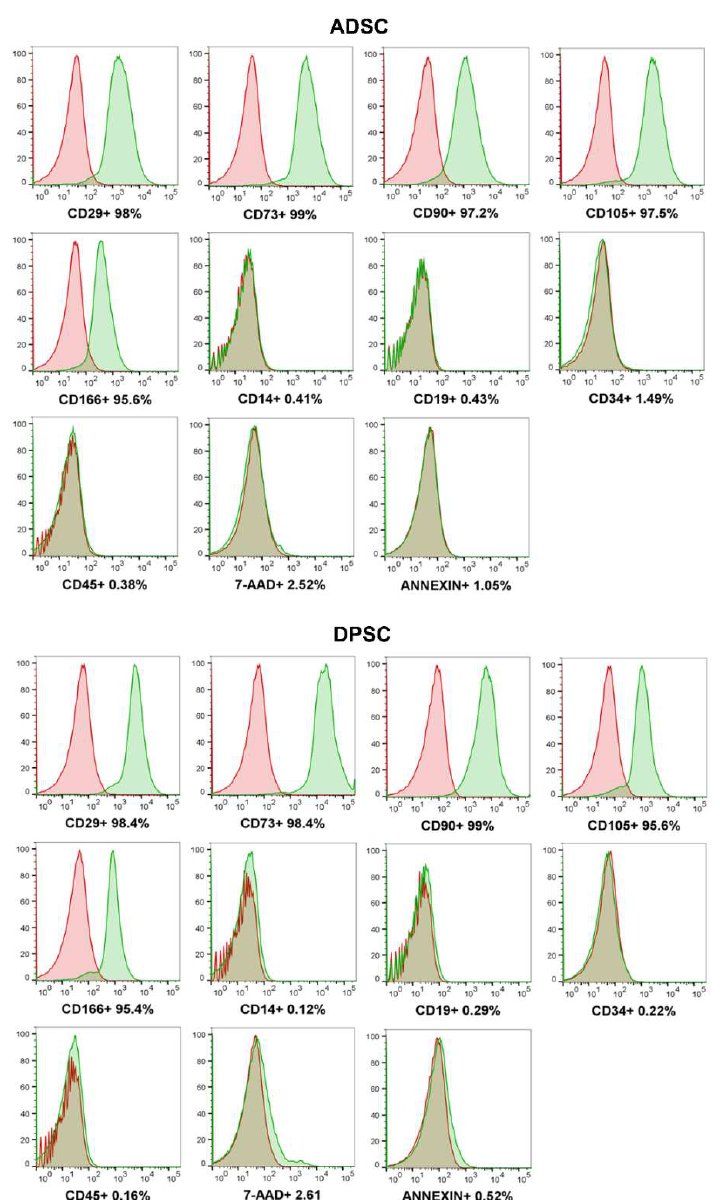
Figure 1. Mesenchymal stromal cell (MSCs) characterisation. Immunophenotypic analysis by flow cytometry of representative ADSCs and DPSCs samples. Green histograms indicate the percentage of the population positive for each antibody, while red histograms indicate the isotype control of the antibodies. ADSCs: adipose tissue-derived stromal cells, DPSCs: dental pulp-derived stromal cells. 2.2. DPSCs do not Differentiate into Adipocytes After 21 Days of Induction Using Two Different Protocols